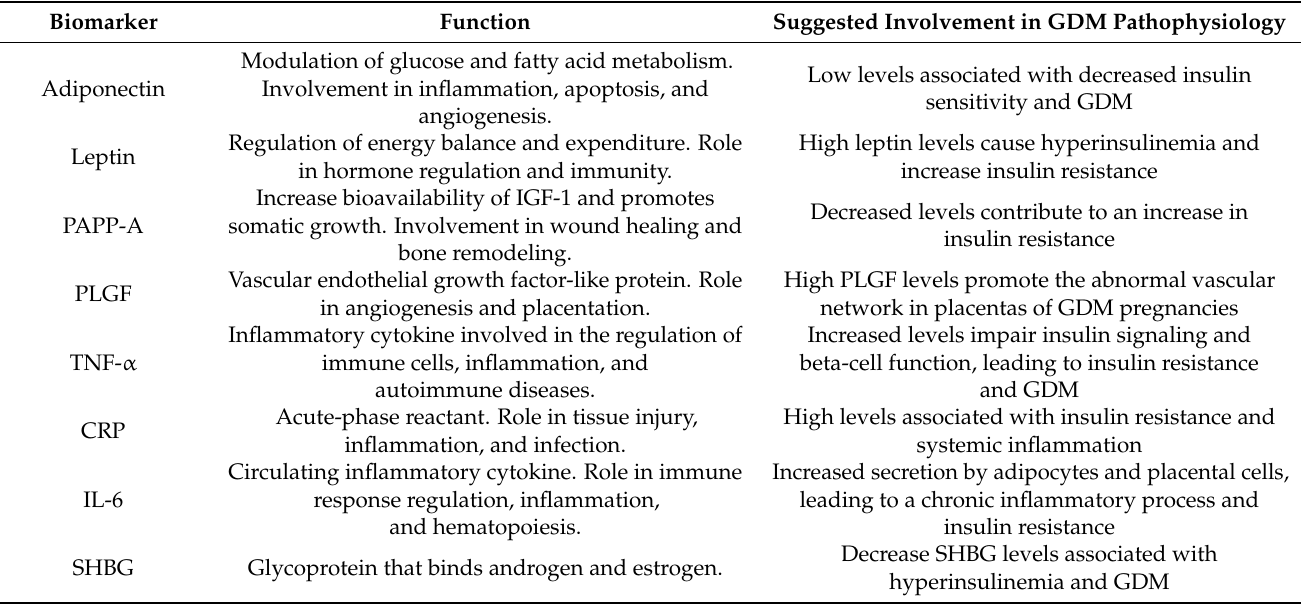
Table 2. Potential biomarkers for gestational diabetes